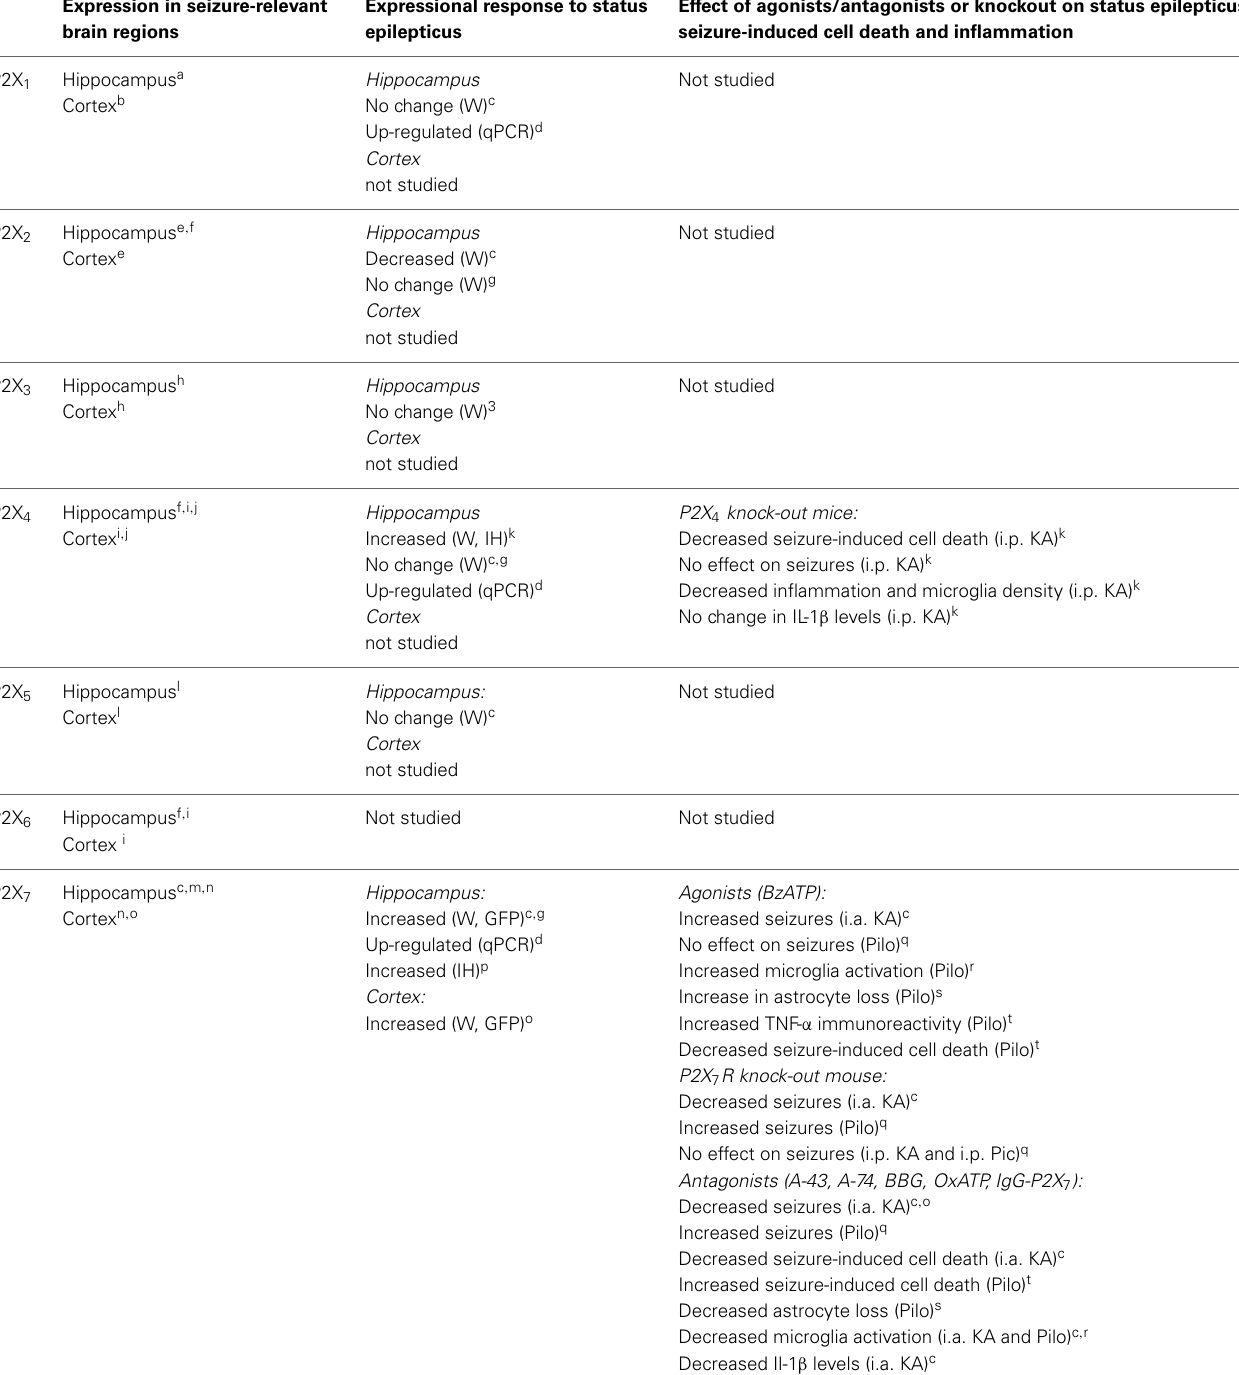
Table 1 | P2X receptors in status epilepticus. Expression in